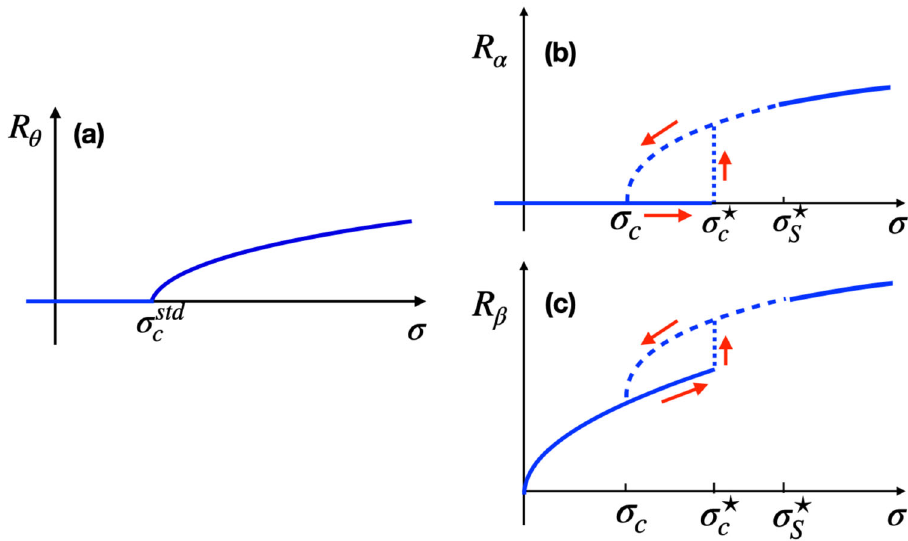
Fig. 2 Schematic phase diagram of Dirac synchronization. The schematic representation of the phase diagram of the standard Kuramoto model with order parameter R θ depending on the coupling constant σ ( a ) is compared with the phase diagram of Dirac synchronization characterized by the two order parameters R α and R β depending on the coupling constant σ ( b , c ). The synchronization transition of the standard Kuramoto model occurs continuously at the synchronization threshold σ std c and the forward and backward transitions coincide. For Dirac synchronization, the forward transition observed for increasing values of σ starting from σ = 0, is discontinuous at σ ? c where we observe an abrupt transition from an incoherent state where R α = 0 (but R β > 0) to a non-stationary coherent state of the complex order parameters with R α > 0 (and R β > 0). This non-stationary coherent phase, also called rhythmic phase, is characterized by non-trivial oscillations of the order parameter X α in the complex plane which are observed at essentially constant absolute value ∣ X α ∣ . This phenomenon occurs in the region indicated here by dashed-lines. For σ > σ ? σ ? fi nite network size, the coherent S , where S diverges in the limit of in state becomes stationary. The backward transition of Dirac synchronization, observed for decreasing values of σ , fi rst displays a transition from a stationary coherent state to a non-stationary coherent state at σ ? S , then displays a continuous phase transition from the non-stationary coherent phase to the incoherent phase at σ c